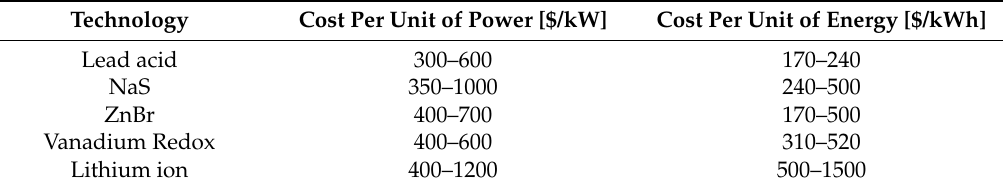
Table 1. Costs Estimation for Different BESS Technologies.